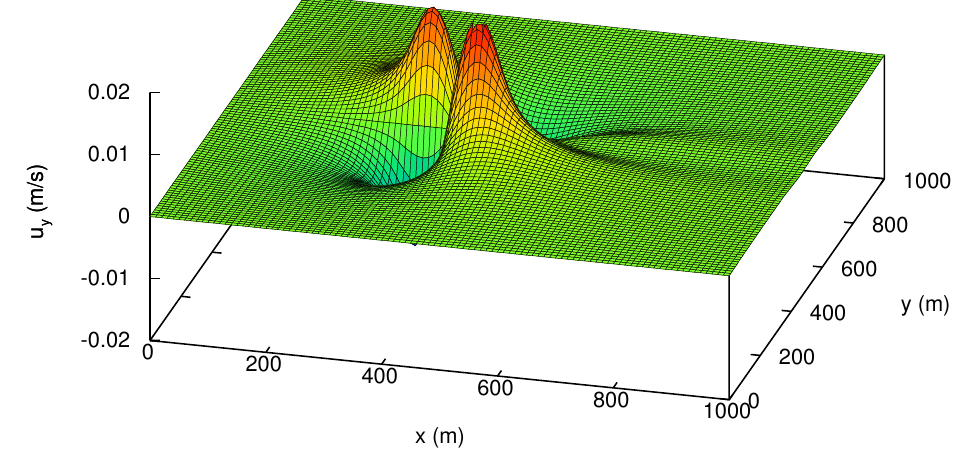
Figure 7. Velocity u y distribution for a steady flow over a 2D